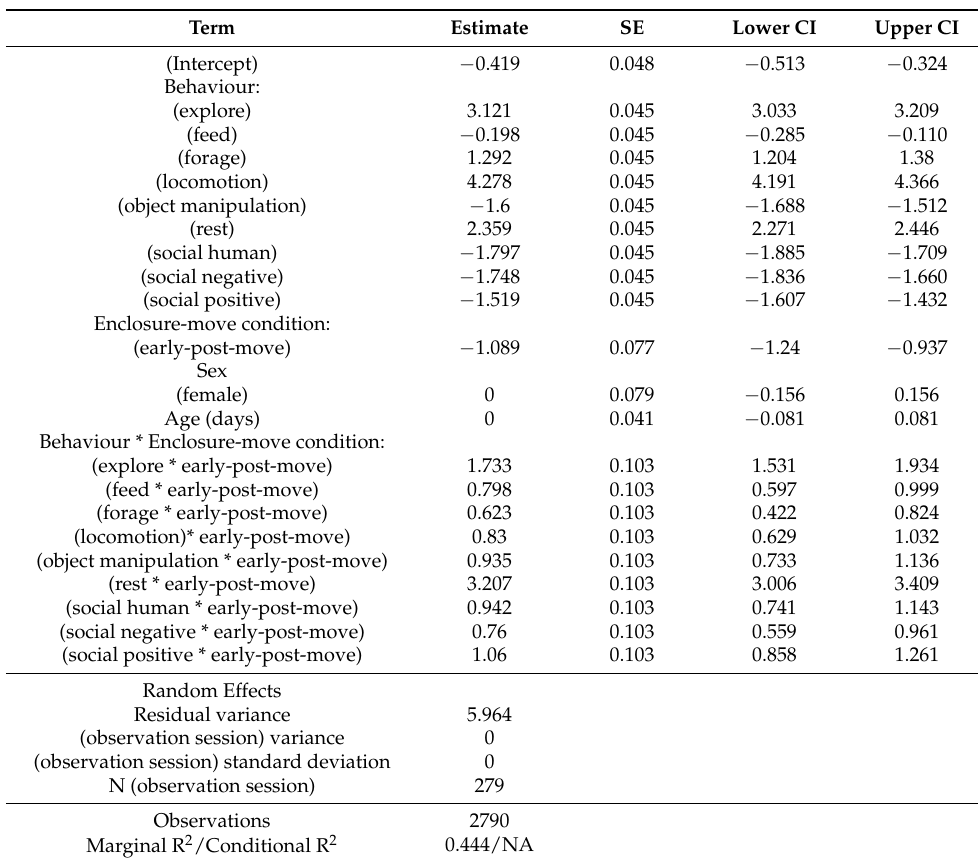
Table A7. Model 3 summary output: Malayan sun bear activity budget.